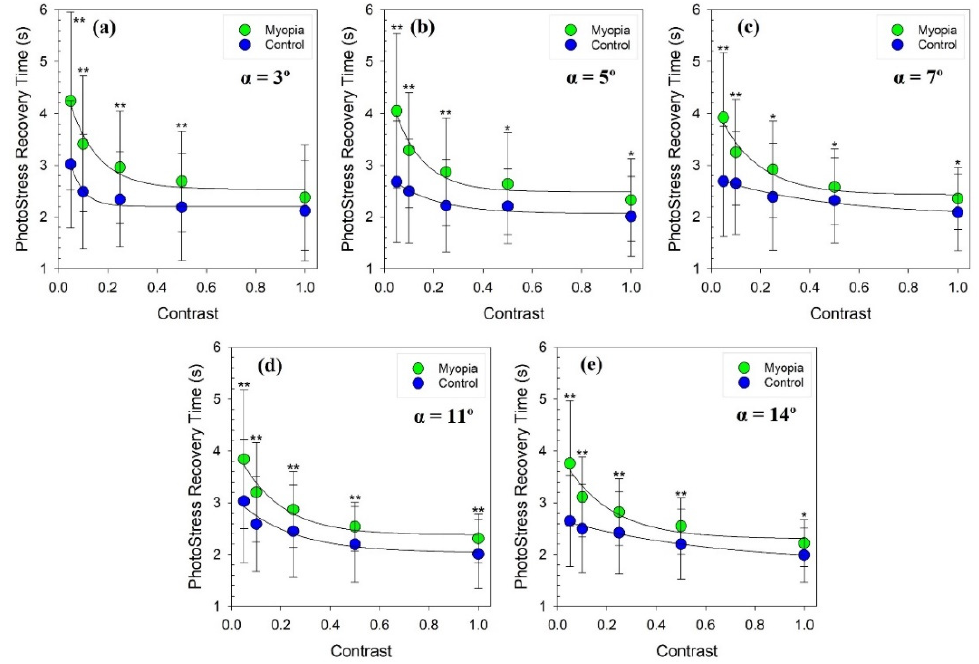
Figure 3. PSRT as a function of the stimulus contrast for each incident angle of the glare source for myopic (green dots) and control groups (blue dots); ( a ): α = 3º; ( b ): α = 5º; ( c ): α = 7º; ( d ): α = 11º and ( e ): α = 14º. The black lines through the dots are non-linear exponential decay regressions fitted to the values. Error bars represent 1 standard deviation. A single asterisk sign (*) was plotted to indicate that statistically significant differences ( p value < 0.05) for PSRT values between groups were found. A double asterisk sign (**) was plotted to point out the significant differences complying with Bonferroni’s correction ( p value <